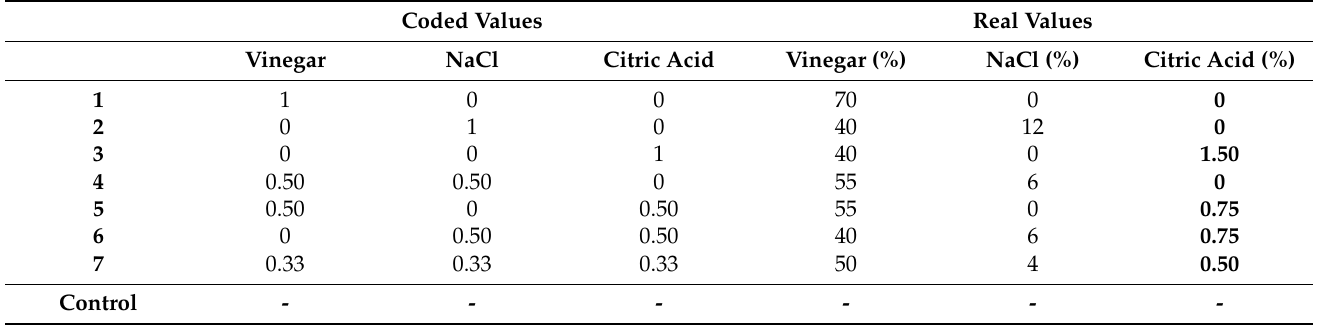
Table 1. Combinations of